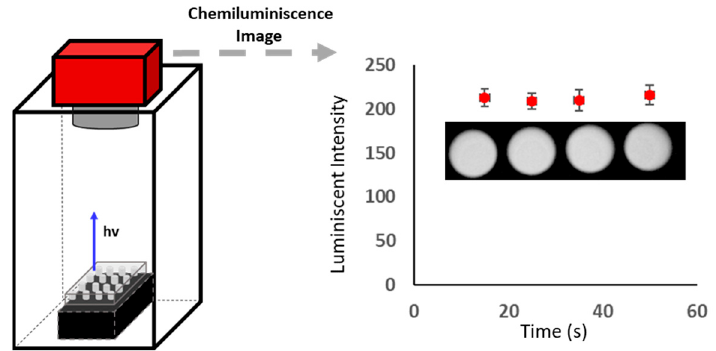
Figure 4. Schematic set ‐ up of the CCD camera to measure CL image, the real image of the variation of the bank signal as a function of time, and the representation of the luminescent intensity for each image.